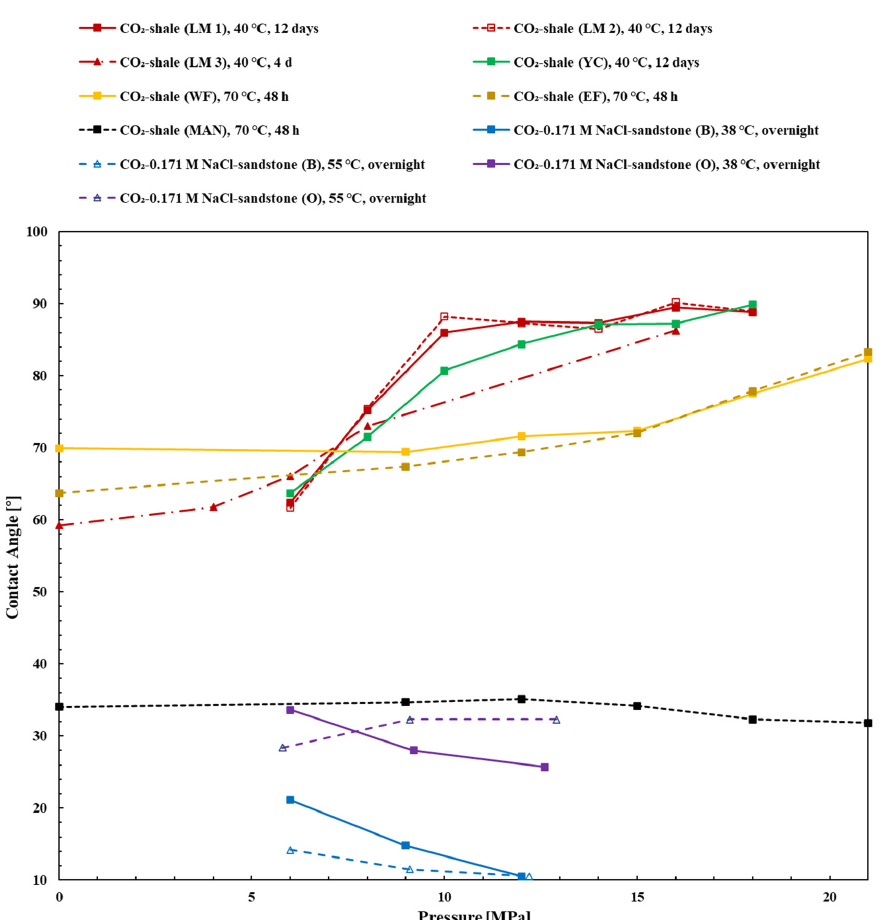
Figure 7. Water contact angle as a function of pressure in the H 2 O-rock systems after reaction with CO 2 [13,29,38,54,55]. 12 days: two days per pressure reaction [13,54]. The data of pressure 0 corresponds to the initial contact angle of rock.